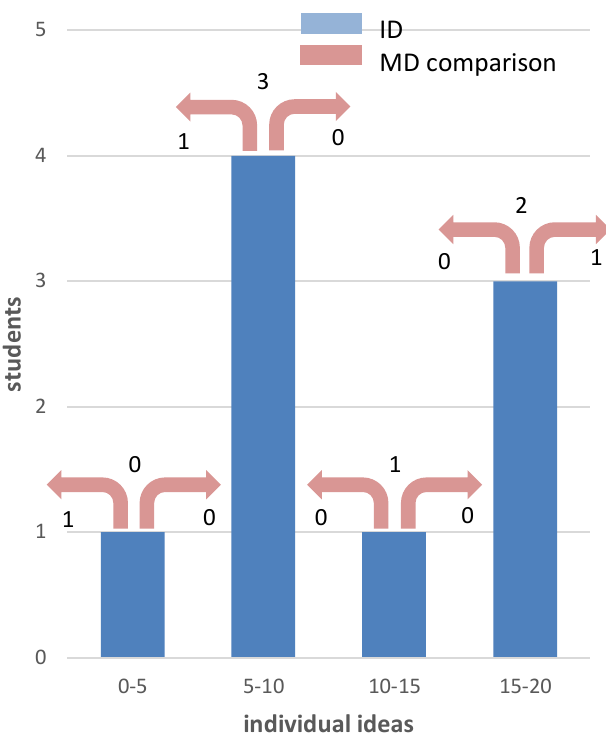
Fig.1. A histogram of the number of individual ideas generated during this ID project in blue. The red arrows show how many students would produce more, equal or less ideas in a MD